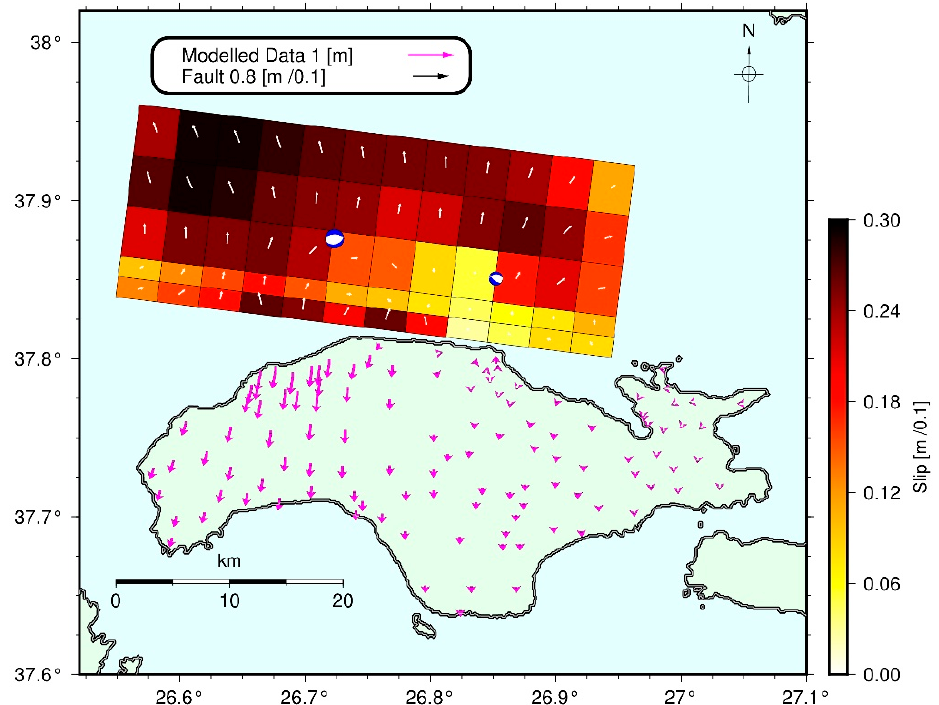
Figure 9. Slip distribution along the fault plane for the preferred model. The upper segment (2 rows) has a dipping angle of 60° and the lower one (3 rows) of 40°. White arrows on the fault plane describe the unit slip vector. Pink arrows on the data points are the modelled horizontal displacement vectors. The focal mechanisms of the earthquake, and the main aftershock are also presented.